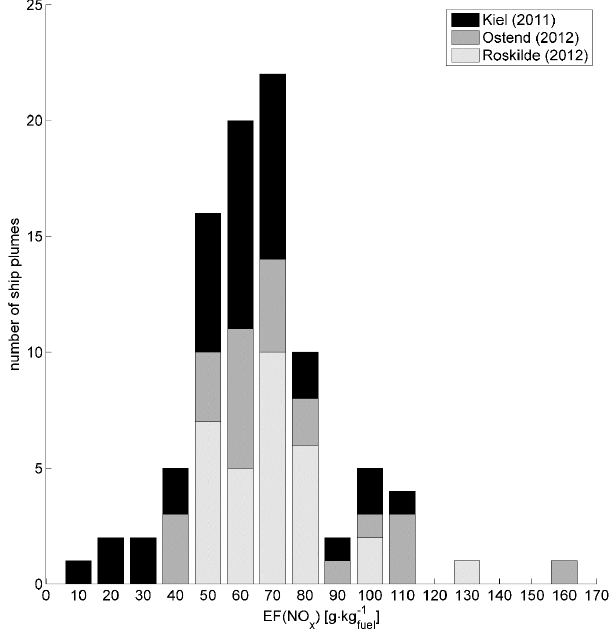
Figure 5. Histogram of the emission factor of SO 2 , EF(SO 2 ) , from airborne measurements for four campaigns (174 ships) in the years Figure 5: Histogram of the emission factor of SO 2 , EF(SO 2 ), from airborne measurements for four 2 2011 and 2012. The inset shows according results from earlier cam- campaigns (174 ships) in the years 2011 and 2012. The inset shows according results from earlier 3 paigns between 2007 and 2009 (127 ships). The comparison indi- campaigns between 2007 and 2009 (127 ships). The comparison indicates a reduction of EF(SO 2 ). This 4 cates a reduction of EF(SO 2 ) . This coincides with the reduction of coincides with the reduction of the limit of sulfer in fuel to 1%. The corresponding values for the sulfur 5 the limit of sulfer in fuel to 1%. The corresponding values for the fuel content can be obtained by dividing the EF(SO 2 ) by 20. 6 sulfur fuel content can be obtained by dividing the EF(SO 2 ) by 20.